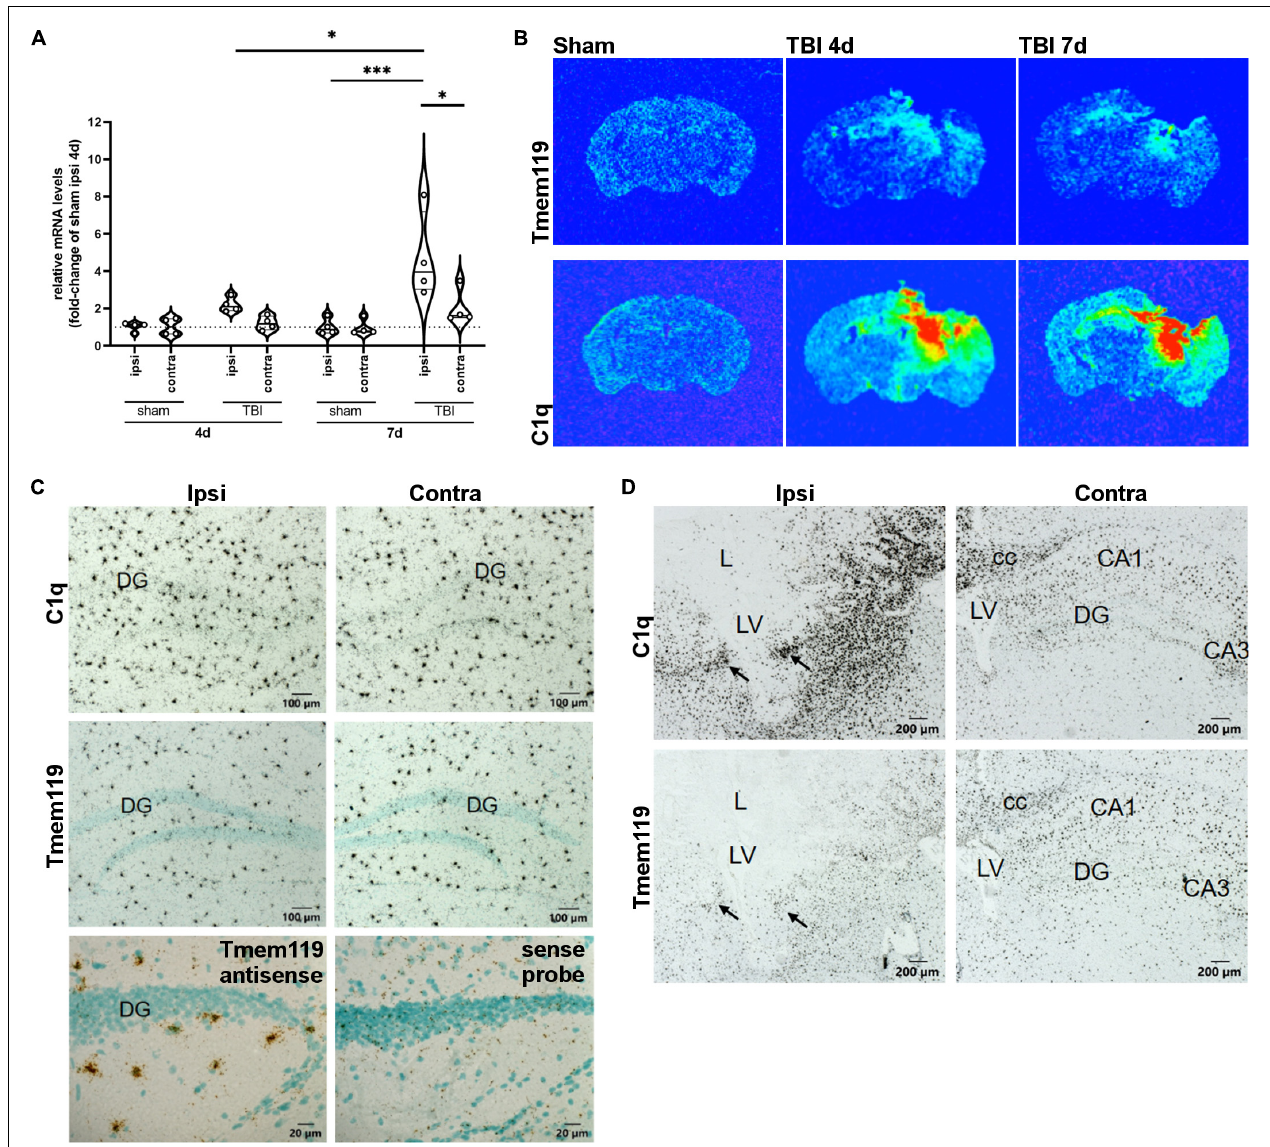
FIGURE 1 | Tmem119 gene expression at 4 or 7 days after sham surgery or TBI. (A) The RNA isolated from brain sections enabled comparison of Tmem119 expression levels ipsilaterally and contra-laterally to the lesion. Data are shown as violin plot with single replicates, a line at median and quartiles, and n = 4. Three-way ANOVA followed by Sidak’s multiple comparison test, ∗∗∗ p < 0.001, ∗ p < 0.05. (B) Representative false color X-ray film images of coronal brain sections of TBI or sham mice after hybridization with 35 S-Labeled RNA probes specific for Tmem119 and C1qa . Exposure times of X-ray films were 48 h for C1q , 70 h for Tmem119 . (C) High magnifications of representative autoradiograms of sham mice at 4 days. Comparing ipsi to contralateral sides, no differences were observed in the scattered microglia-like distribution pattern of Tmem119 mRNA and C1qa mRNA expressing cells. Control staining with anti-sense probes produced specific Tmem119 ISH signals in microglia, but not in neurons or other cell types. In contrast, sense probes used as negative controls produced a background but no specific cellular staining. Scale bars 100 µ m or 20 µ m. (D) High magnifications of representative autoradiograms of TBI mice at 4 days. Numerous densely